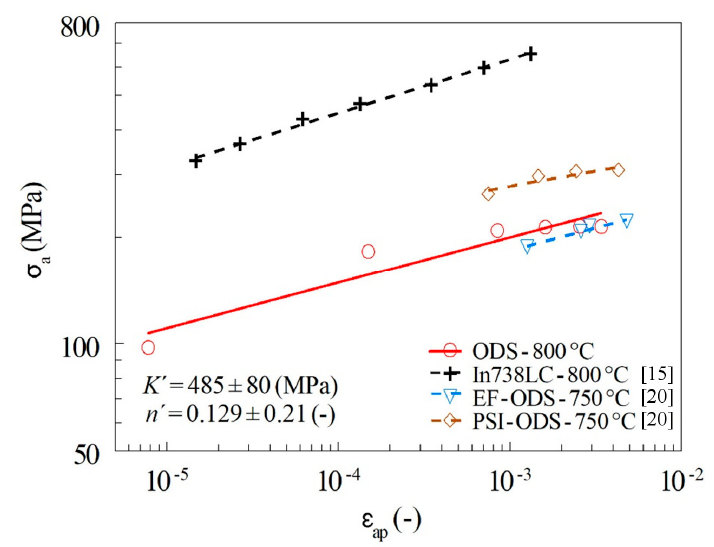
Figure 7. Cyclic Stress Strain Curve (CSSC) obtained using incremental step test method for the ODS alloy and comparison with similar results for Inconel 738 LC [15] and CSSCs for two types of ODS steels (ferritic–martensitic EF–ODS and ferritic PSI–ODS) [20].